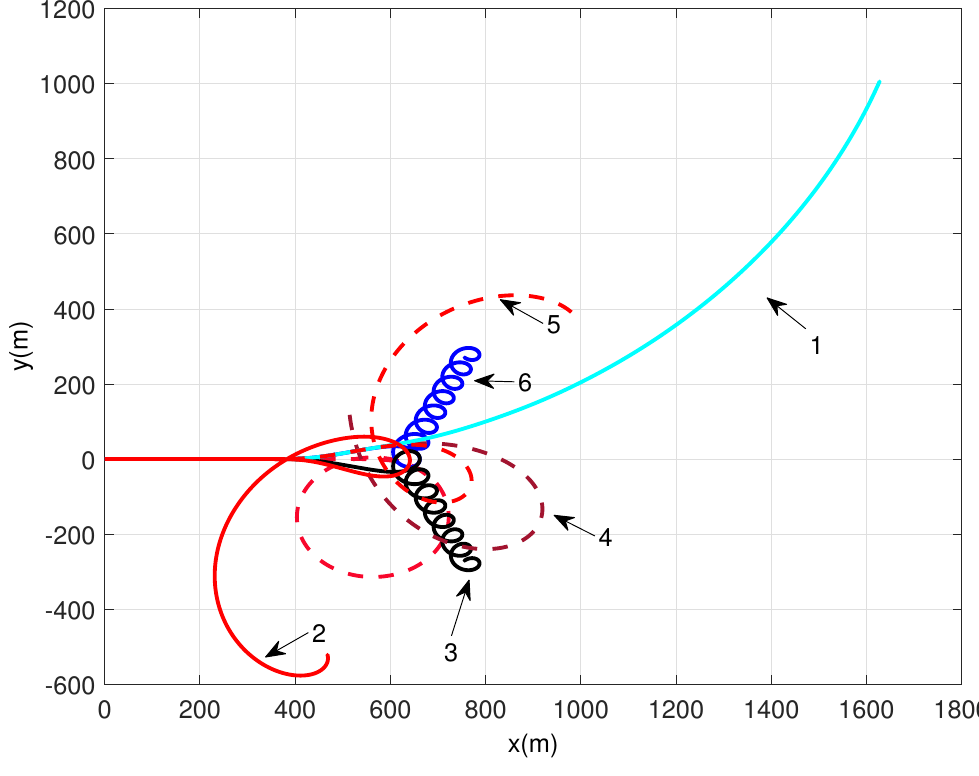
Figure 5. Trajectories of the parafoil system with wind fields.